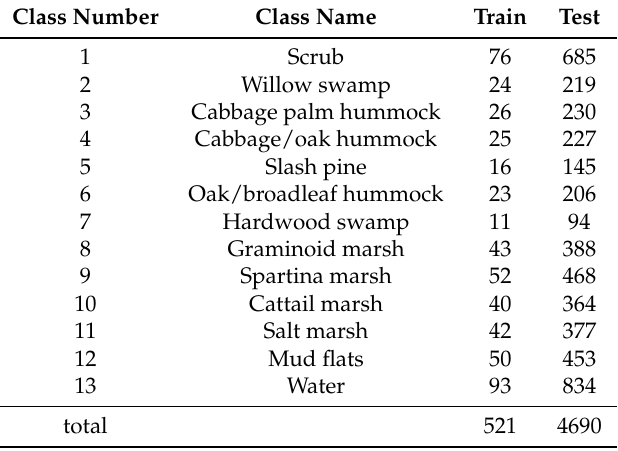
Table 4. Groundtruth classes for KSC scene and the corresponding number of training samples and testing samples for classification